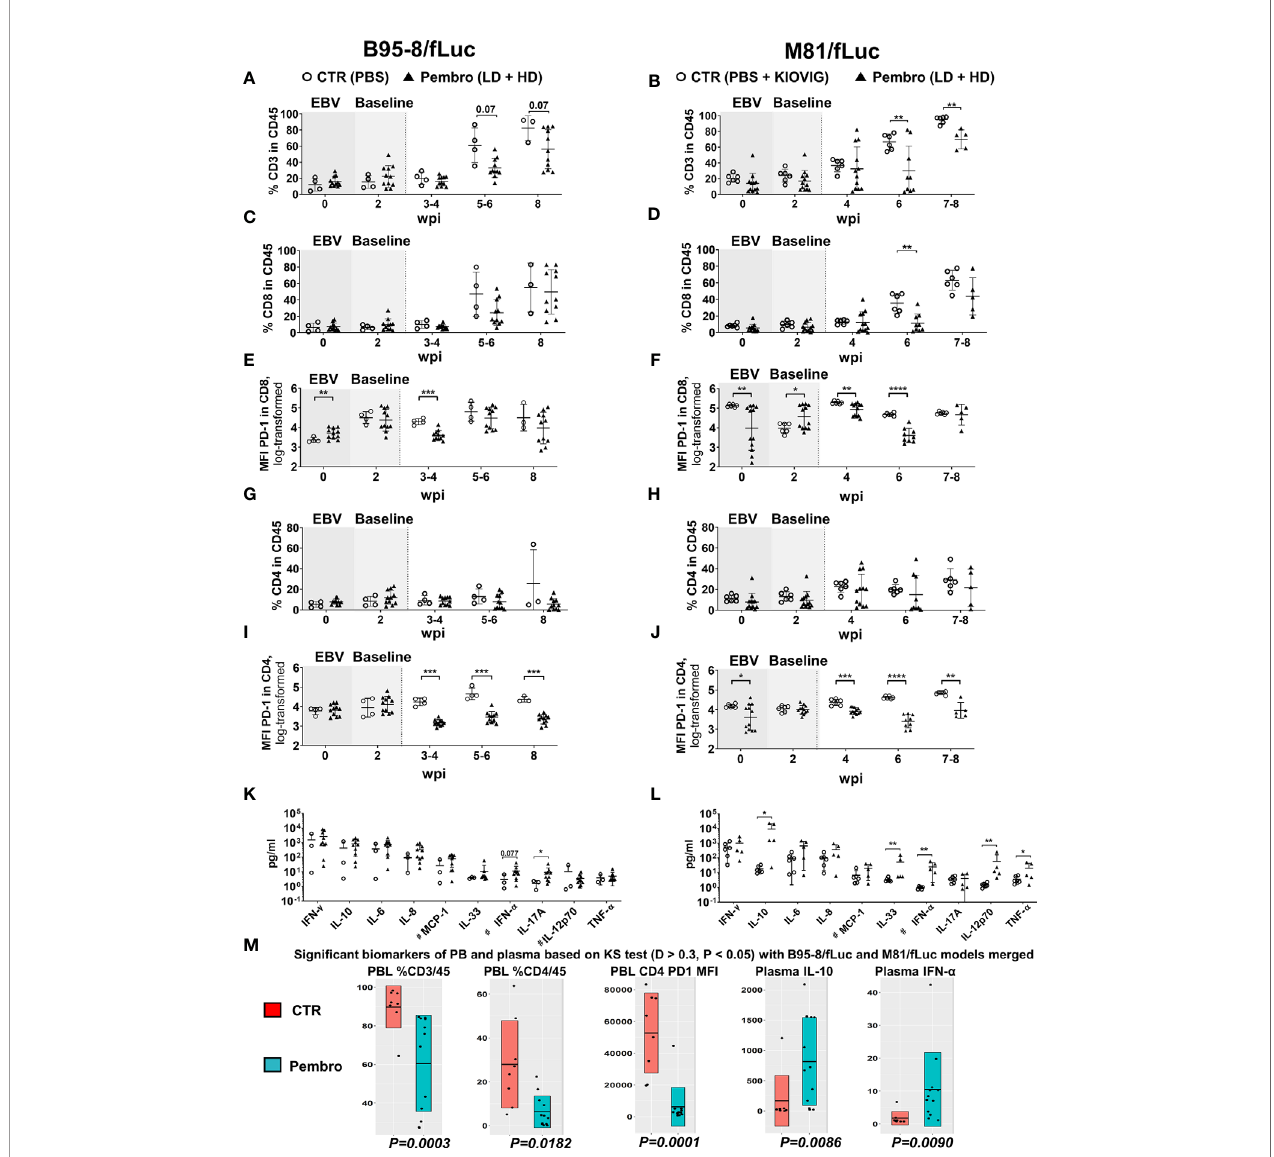
FIGURE 4 | Reduced frequencies of human T lymphocytes in peripheral blood and increased concentrations of human cytokines in plasma after PD-1 blockade during active EBV infections. Peripheral blood was collected on the day prior to EBV infection (time-point 0) and 2 weeks post-infections (wpi), as baseline values for randomization (shaded graphs). Non-treated control mice (CTR, open circles) and pembrolizumab treated cohorts are shown ( fi lled triangles; low-dose and high-dose treatments were merged for the analyses, each dot represents a mouse analyzed at the corresponding time point). After initiation of pembrolizumab treatment, peripheral blood was collected at 3 – 4, 5 – 6, and 8 wpi. The different EBV infection models (B95-8/fLuc; left panels and M81/fLuc; right panels) were analyzed separately regarding lymphocytes and cytokines and then the data was merged for power analyses and identi fi cation of markers associated with response. (A – J) Flow cytometry analyses of peripheral blood lymphocytes. (A, B) Frequencies (%) of human CD45 + /CD3 + lymphocytes were reduced after pembrolizumab treatment. (C, D) Frequencies (%) of human CD45 + /CD8 + lymphocytes were reduced after pembrolizumab treatment. (E, F) Mean fl uorescence intensities (MFI) of PD-1 detected on the surface of CD8 + T cells were reduced after pembrolizumab treatment. (G, H) Frequencies (%) of human CD45 + /CD4 + lymphocytes were reduced after pembrolizumab treatment. (I, J) MFI of PD-1 detected on the surface of CD4 + T cells were signi fi cantly reduced after pembrolizumab treatment. Statistical analyses for fl ow cytometry data was performed using unpaired t test with Welch ’ s correction. Standard deviation is indicated. *P < 0.05, **P < 0.01, ***P < 0.001, ****P < 0.0001 . (K, L) Concentration human cytokines (pg/ml) at 8 wpi showing elevation for several cytokines in plasma of mice infected B95-8/fLuc (K) or M81/fLuc (L) treated with pembrolizumab. Mann-Whitney t test was used to compare the control and treatment groups. Standard deviation is indicated. *P < 0.05, **P < 0.01 . # indicates parameters with some values being beyond the lower limit of detection (LOD), LOD was used for these samples to analyze the differences. (M) Global analysis for power analyses and identi fi cation of T cell and cytokine patterns at 8 wpi. The datasets from the